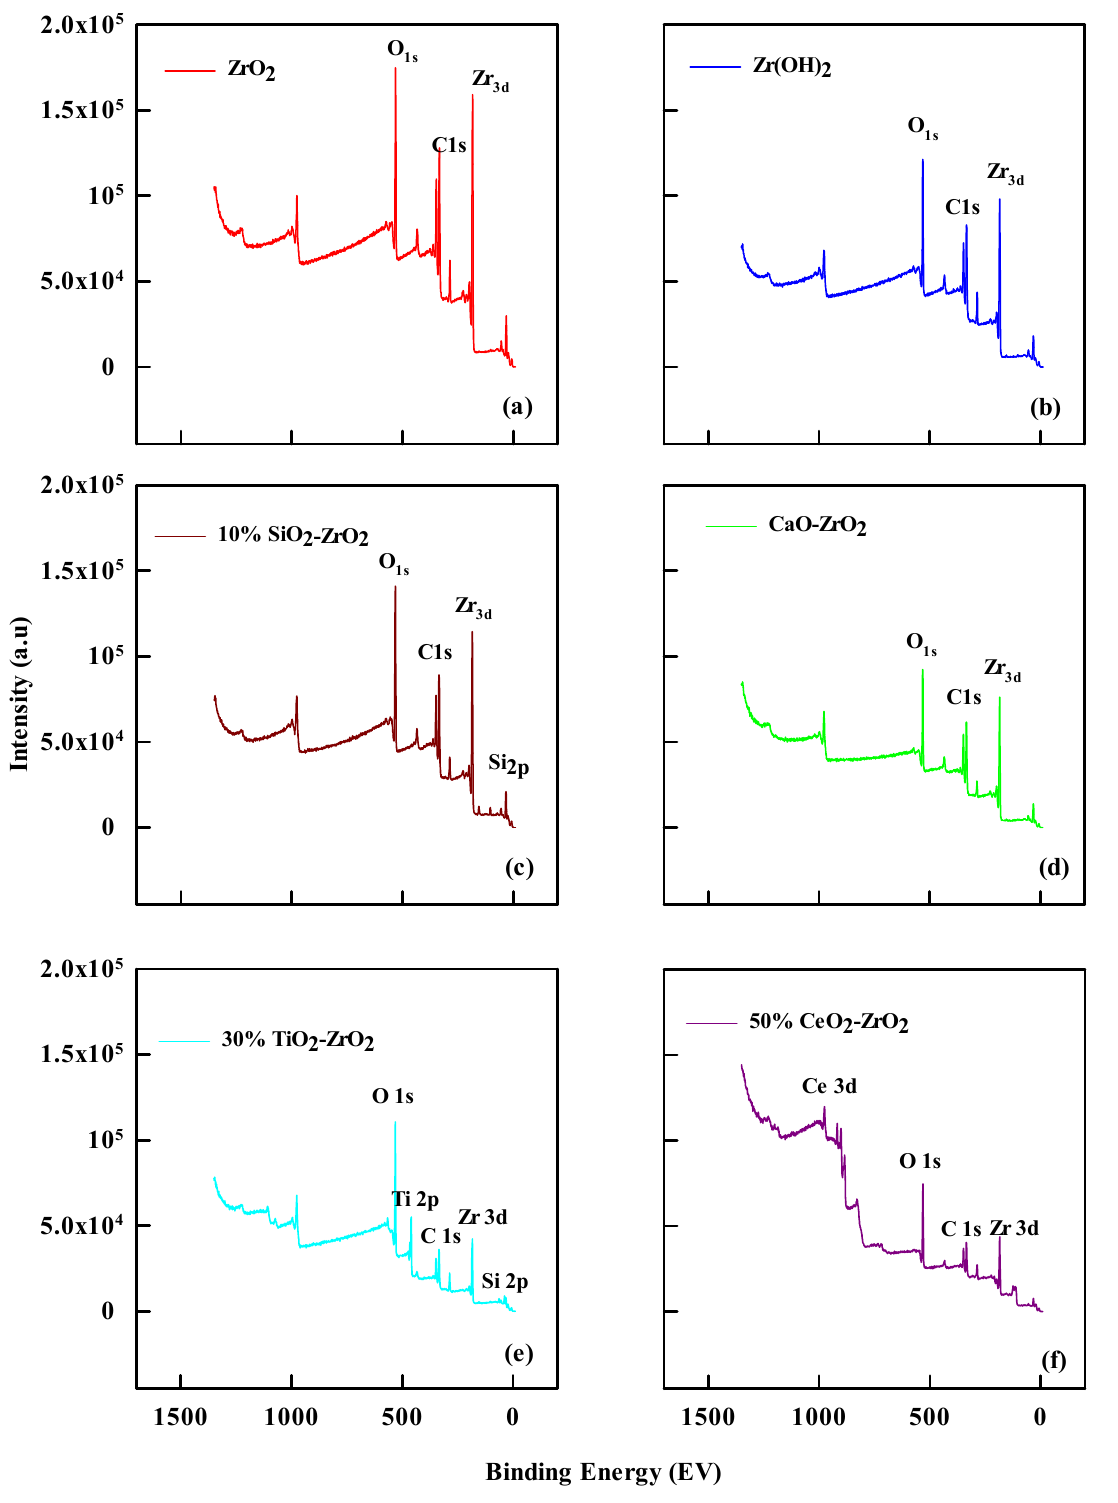
Figure 2. XPS profile for ( a ) ZrO 2 , ( b ) 10% SiO 2 -ZrO 2 , ( c ) Zr(OH) 2 ( d ) 2% CaO-ZrO 2 ( e ) 30% TiO 2 -ZrO 2 , and ( f ) 50% CeO 2 -ZrO 2 .